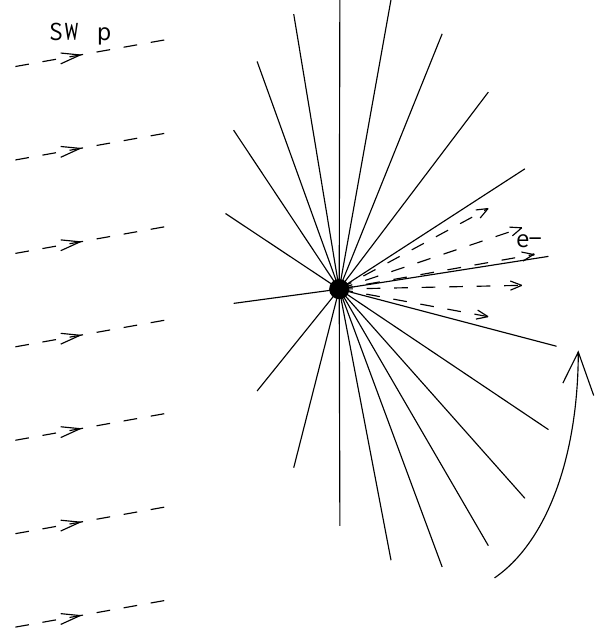
Fig. 1. Schematic description of the original spinning, positive polarity electric sail. Charged, centrifugally stretched tethers gather momentum from the solar wind. The charging is maintained by an electron gun mounted on the spacecraft (middle).